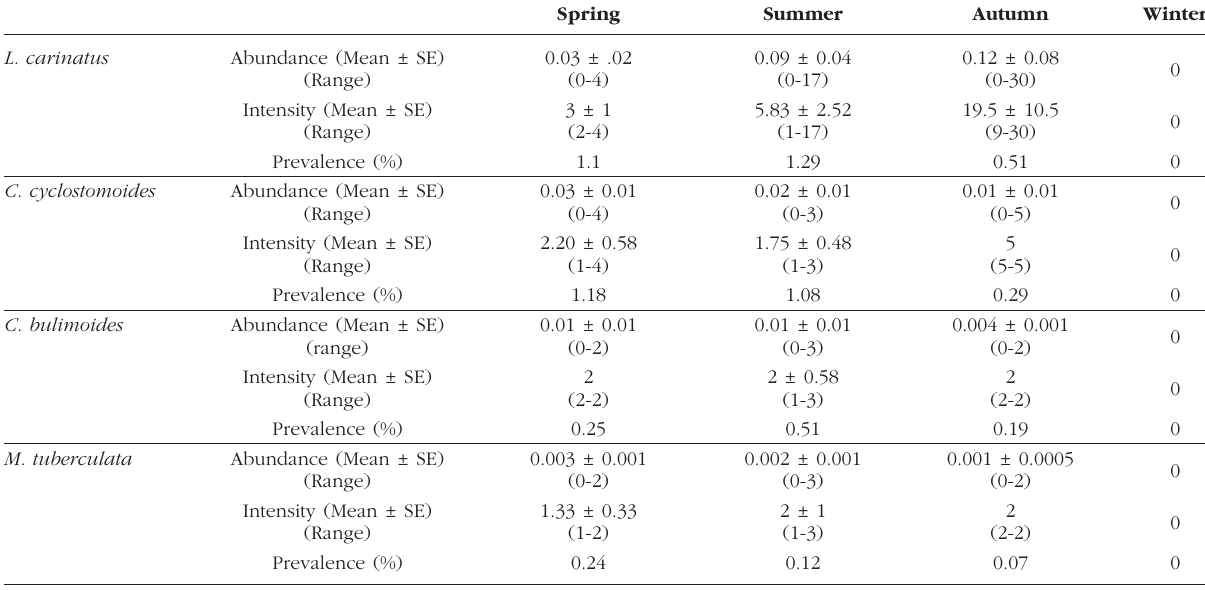
Table II. – Seasonal prevalence, mean abundance and intensity of P. cantonensis larvae infection among different freshwater snails in Al- Salam Canal.